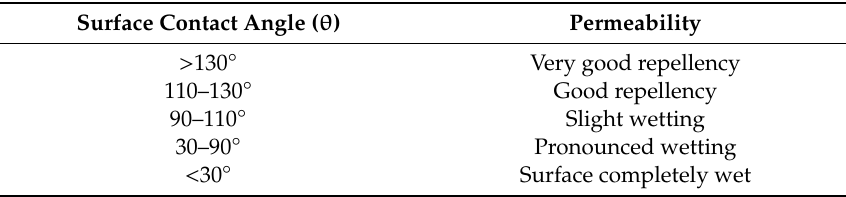
Figure 6. Specimen for contact angle measurement test. Table 6. Water penetration according to contact angle .